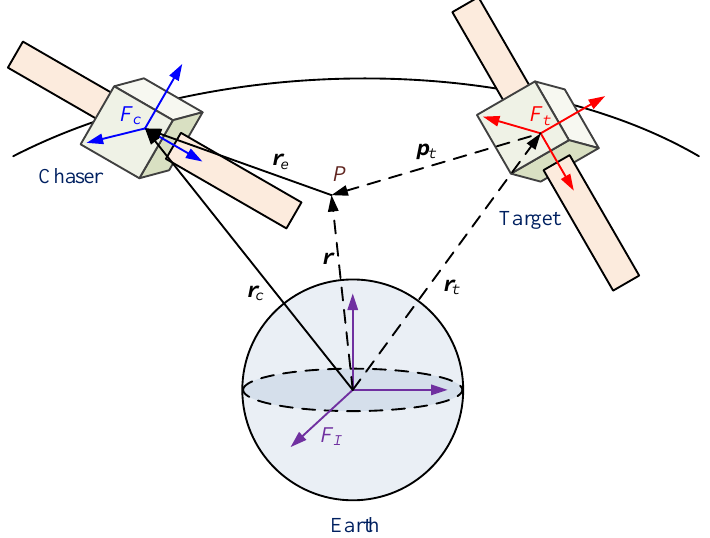
Figure 1. Diagram of the spacecraft proximity operation system.